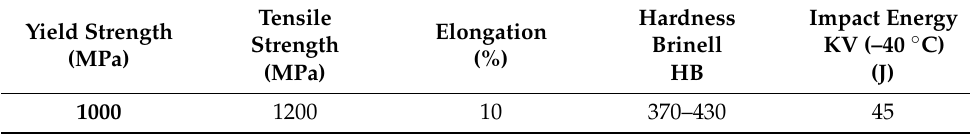
Table 2. Mechanical properties of the steel Hardox Table 1. Chemical composition of steel Hardox 400 (% wt.).